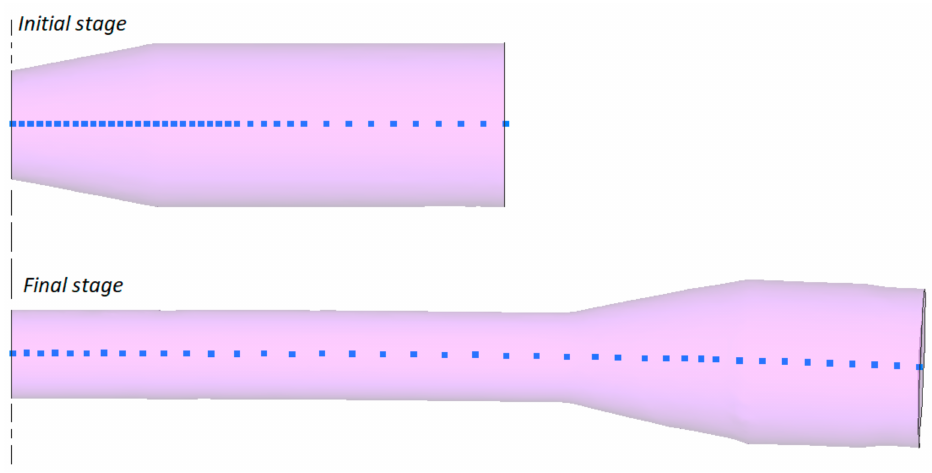
Figure 11. Location of virtual sensors used for registering stress and